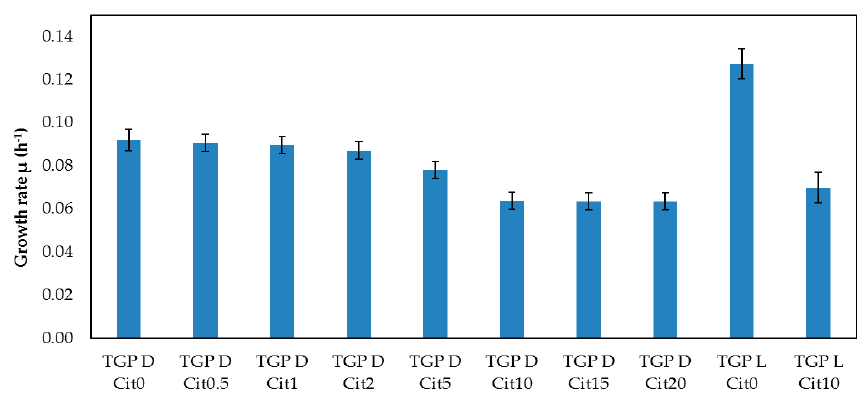
Figure 2. Effect of neutralized (pH = 7) citrate buffer on Chlorella growth in TGP (1 g/L glucose) medium. Different neutralized citrate buffer loadings: 0%, 0.5%, 1%, 2%, 5%, 10%, 15%, 20% are marked: Cit0, Cit0.5, Cit1, Cit2, Cit5, Cit10, Cit15, Cit20, where 100% neutralized citrate buffer is ~0.05 M. Heterotrophic (D-Dark) growth in photobioreactor at 0 µ E m − 2 s − 1 . Mixotrophic (L-Light) growth in photobioreactor at 75 µ E m − 2 s − 1 . Temperature of cultivation: 25 ◦ C. Number of